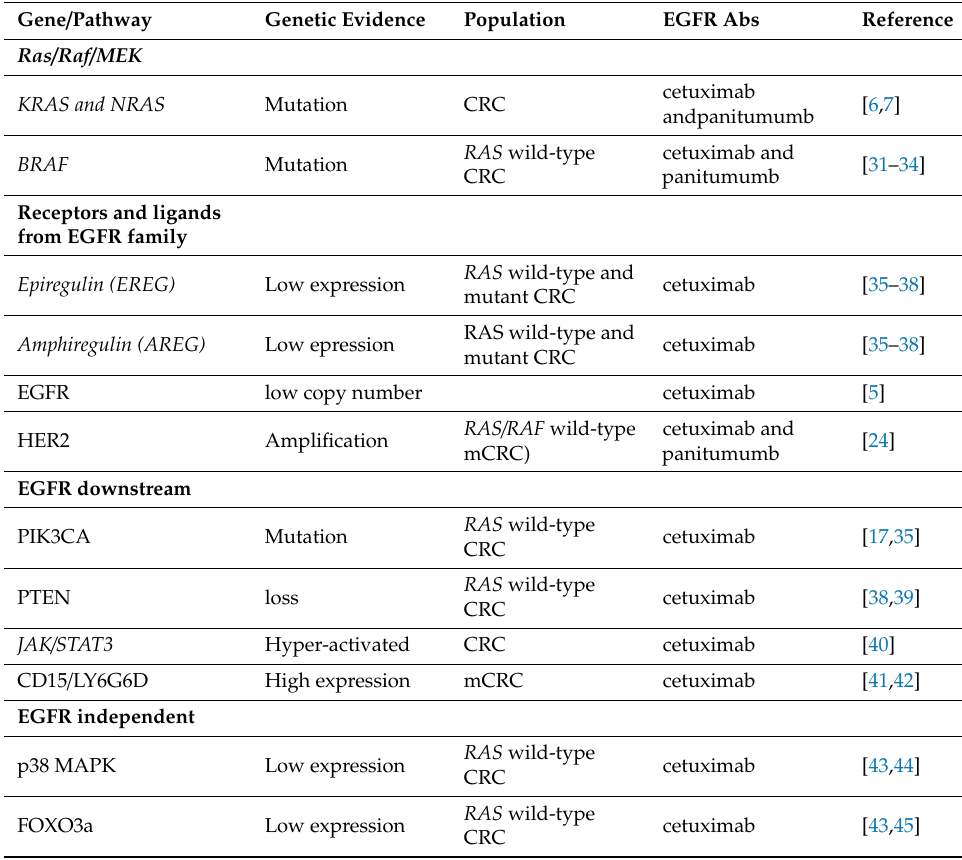
Table 1. Current and emerging predictive biomarker for lack of e ffi cacy to anti-epidermal growth factor receptor (EGFR) antibodies therapy in colorectal cancer (CRC) patients.